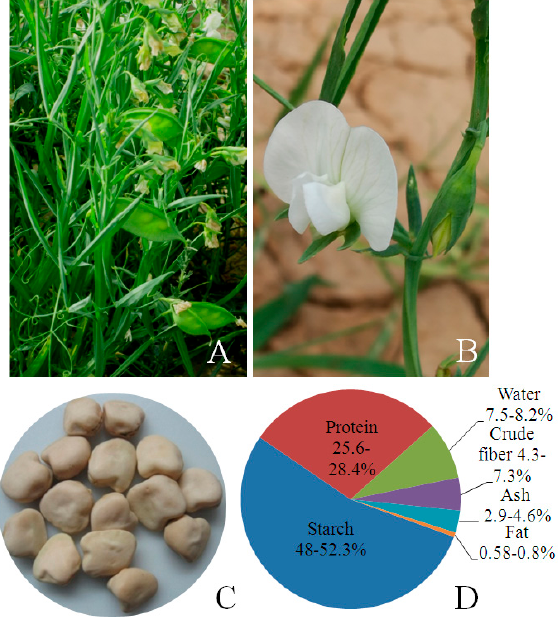
Figure 1. Lathyrus sativus (grass pea), an annual legume cultivated in arid and semiarid areas, has attractive flowers ( A , B ) and yields nutritious seeds ( C ). The seeds are a rich source of protein and starch ( D ).